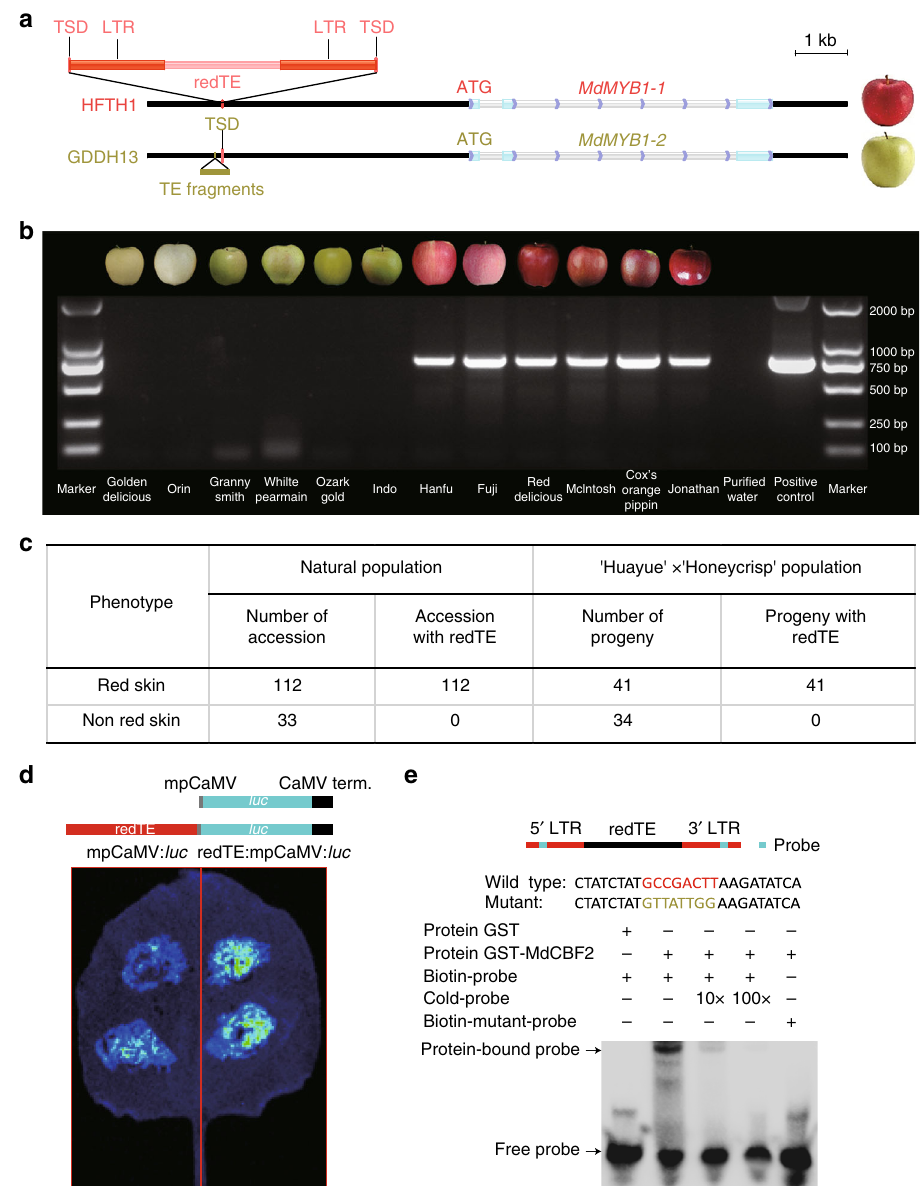
Fig. 4 Red phenotype of apple associated with an LTR retrotransposon. a Molecular structure of MdMYB1-1 and MdMYB1-2 alleles with fl anking sequences. The insertion sites upstream of MdMYB1-1 and MdMYB1-2 are indicated by a red line (HFTH1) and golden yellow line (GDDH13), respectively. b Images of 12 well-known apple varieties with non-red or red skin colour (upper panel) and PCR-based screen showing the absence (right) or presence (left) of the LTR retrotransposon insertion in the upstream of MdMYB1 . A 750 bp fragment corresponding to the partial of redTE that is absent in non-red-skinned varieties (lanes 1 to 6) and is present only in red-skinned varieties (lanes 7 to 12). Lane 13, control check (puri fi ed water was used as the template), Lane 14, positive control. c PCR-based analysis of the redTE insertion in 145 accessions and the F1 segregating population from the cross of Huayue × Honeycrisp. d Constructs and transient expression assays showing that redTE obviously enhanced the luciferase expression levels. Upper panel, the mpCaM: luc (up) and redTE:mpCaM: luc (down) construct backbone consists of the minimal promoter from the cauli fl ower mosaic virus (mpCaMV, grey box), luciferase ORF and cauli fl ower mosaic virus terminator (black box). Lower panel, Luciferase image of Nicotiana benthamiana leaves 72 h after in fi ltration with the Agrobacterial strains containing mpCaM: luc (left), and redTE:mpCaM: luc (right), respectively. e MdCBF2 binds directly to the cis-acting element GCCGACTT. Source data of Fig. 4b, d are provided in Source Data fi le